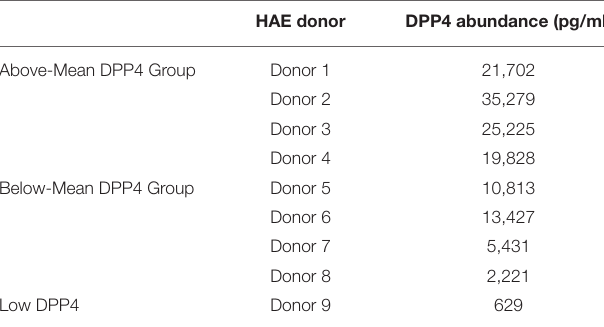
TABLE 2 | Cellular DPP4 abundance in HAE donor specimens used for MERS-CoV infection studies. HAE